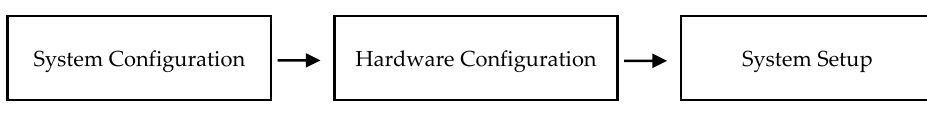
Figure 2. Block diagram of the proposed methodology.